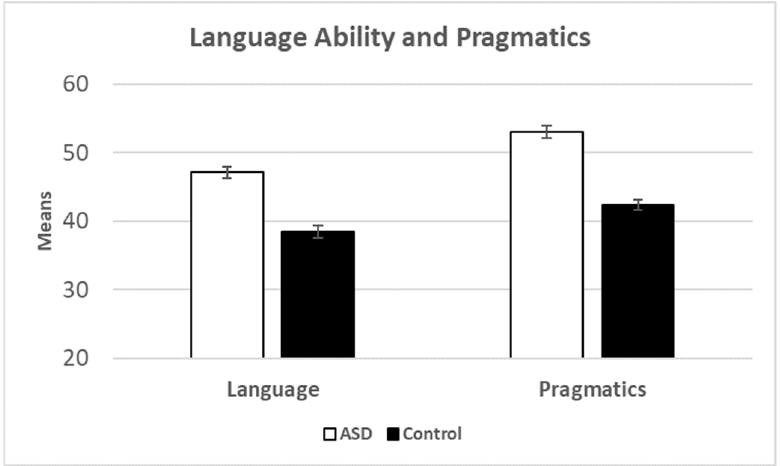
Figure 1. Means for language ability and pragmatics broken down by group. Error bars show the standard error of the mean.